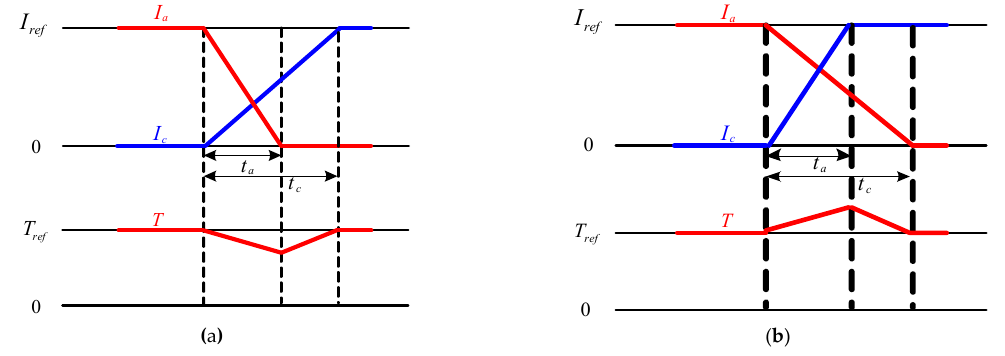
Figure 5. Phase currents during commutation. ( a ) | dia/dt |>| dic/dt |. ( b ) | dia/dt |<| dic/dt |.